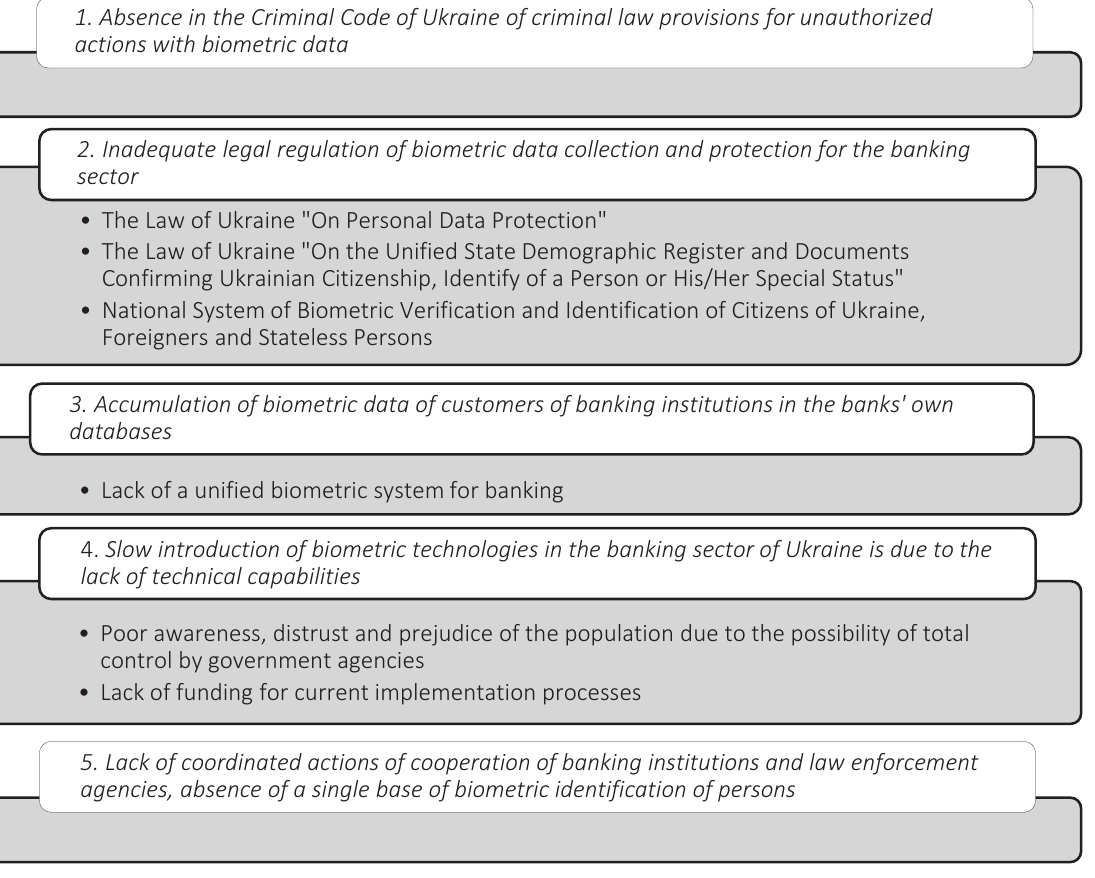
Figure 1. Factors hindering the introduction of biometric technologies in the field of banking in